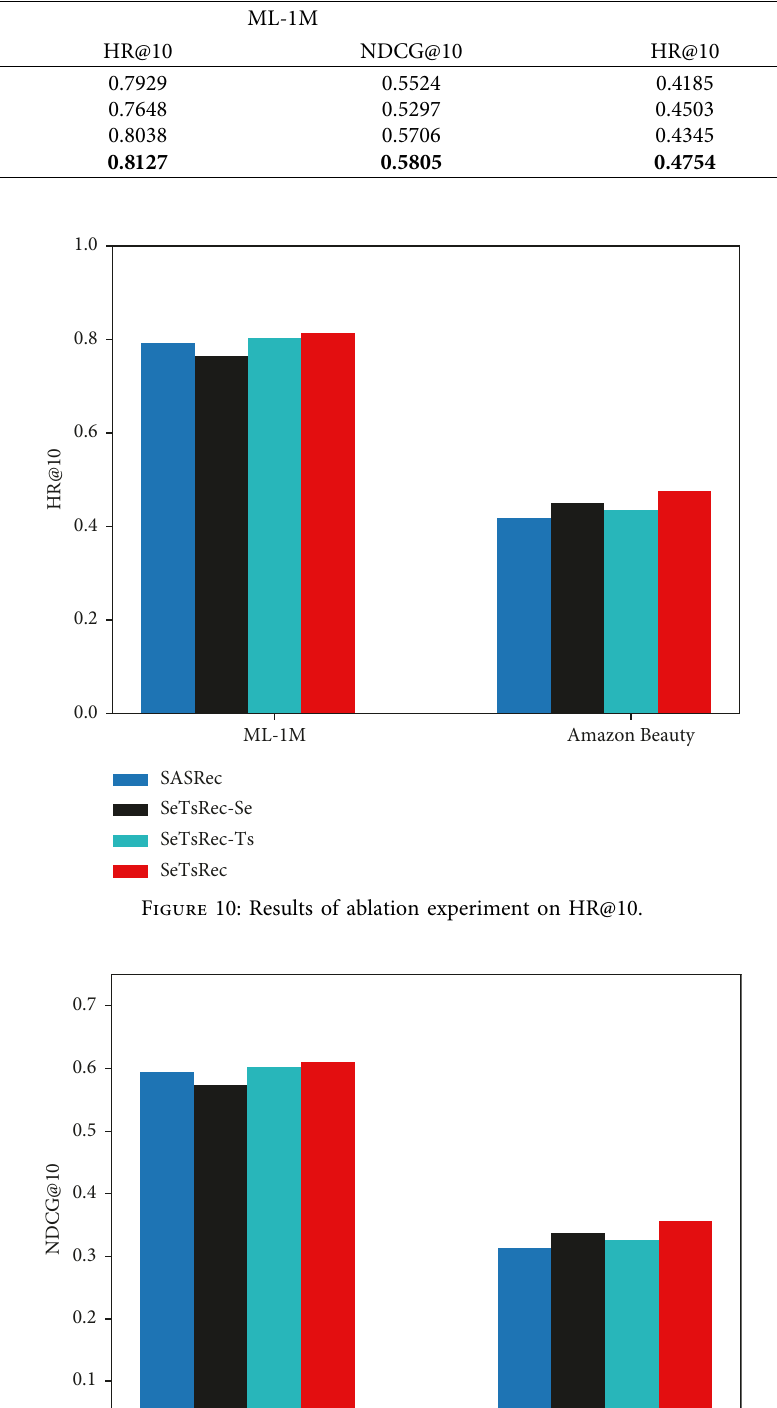
Table 4: Results of ablation